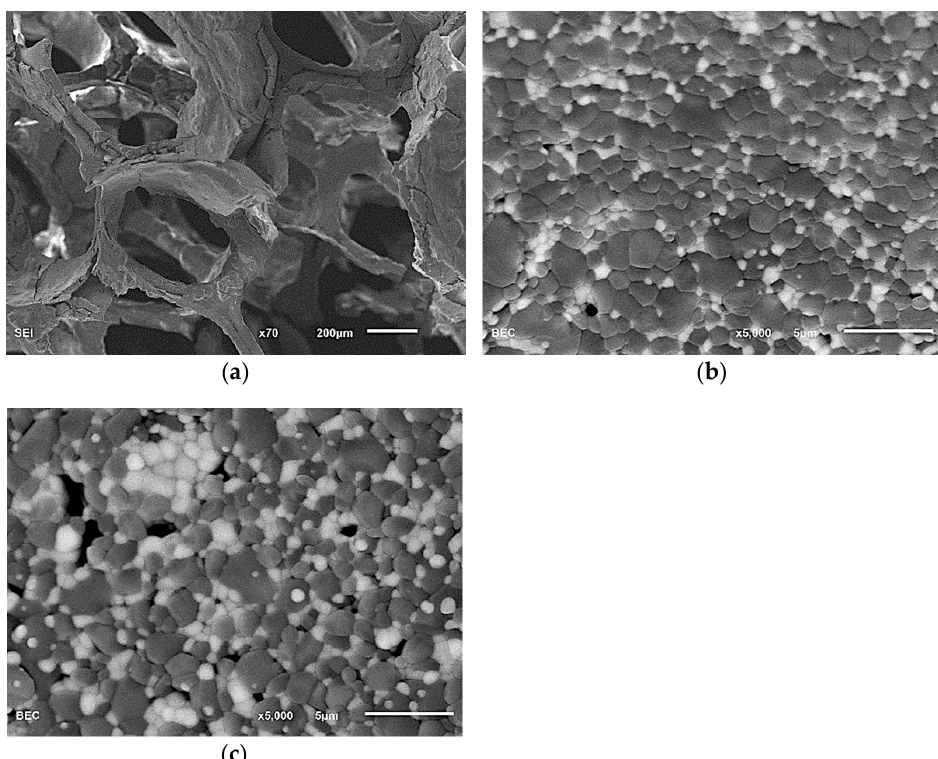
Figure 9. ( a ) Typical scanning electron microscopy image of the strut walls of a reticulated porous ZTA specimen without PVA, and ( b ) typical backscattered electron images of reticulated porous ZTA specimens when the amount of PVA at 2 wt.% and ( c ) at 10 wt.%.